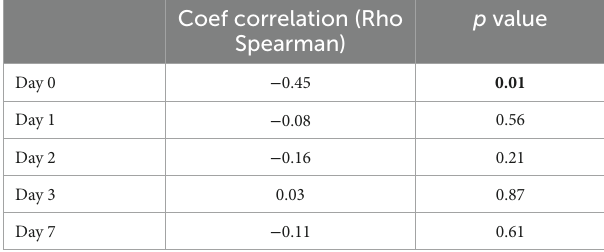
TABLE 4 Levels of CRP in days 0–7 within the study cohort